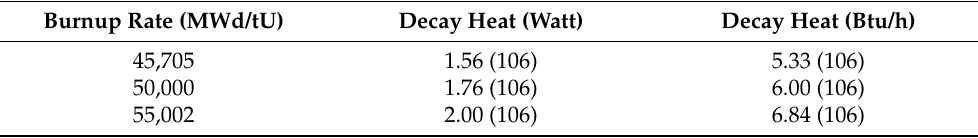
Table 3. Estimated total decay heat of Kori units 3 and